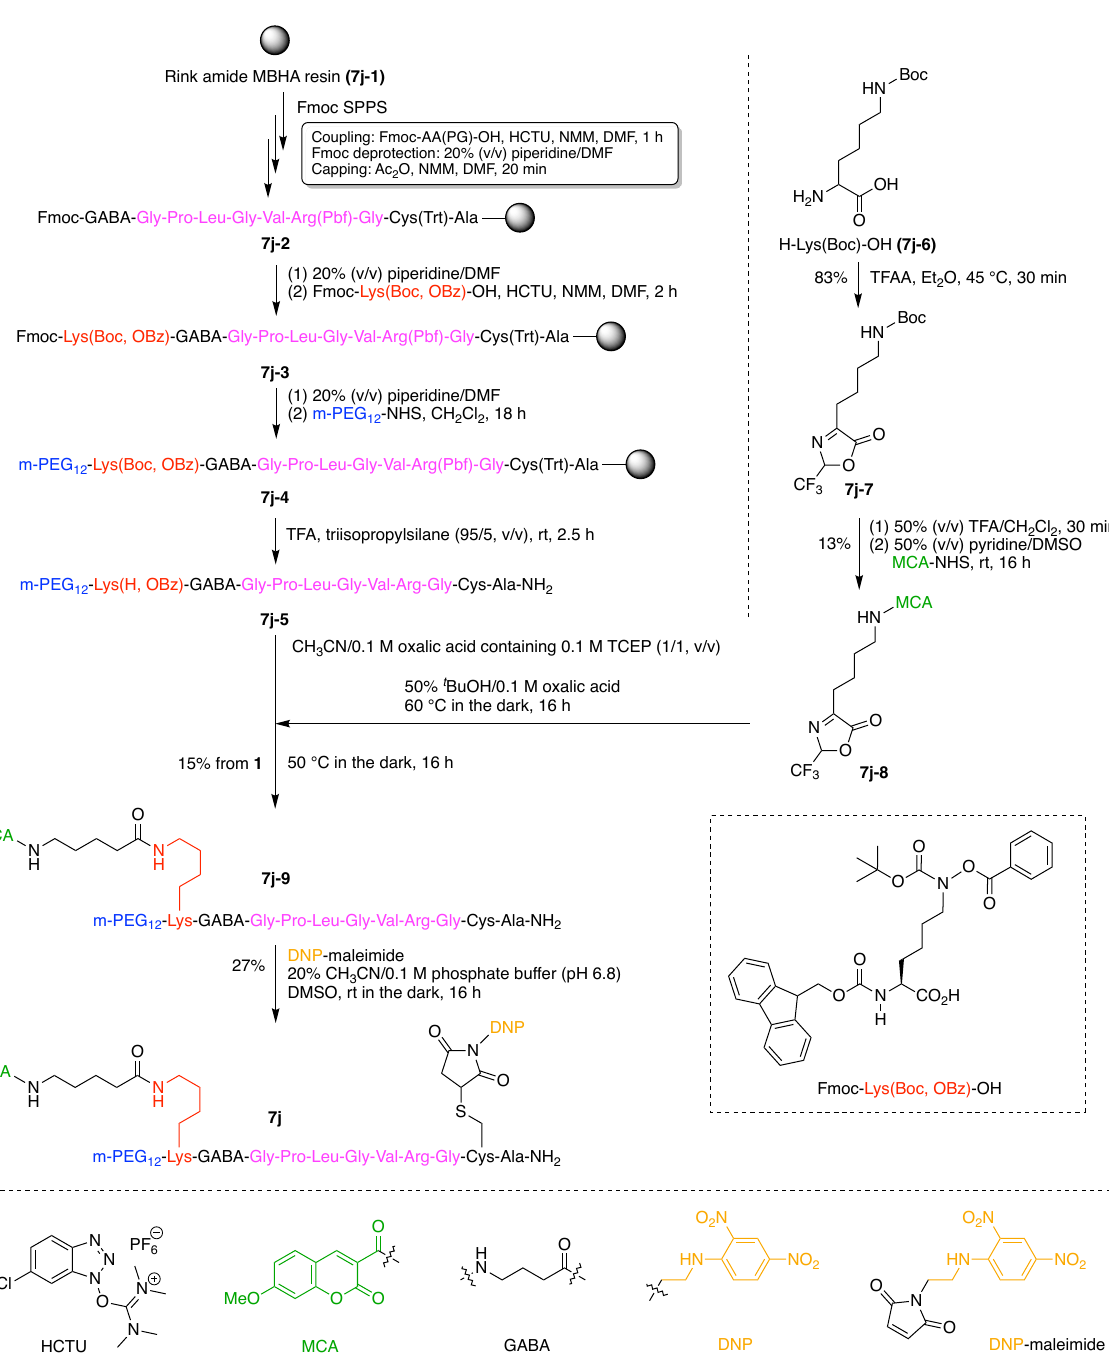
Figure 15. Synthesis of an ABCD-peptide.